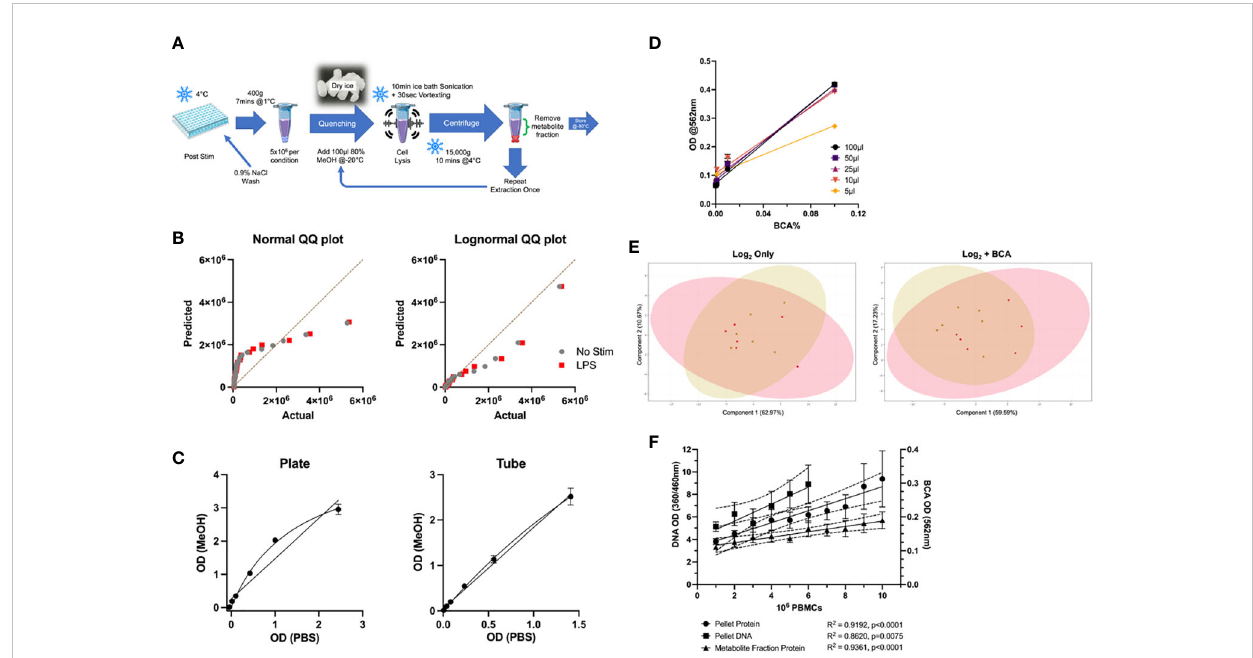
FIGURE 1 Optimisation of LC-MS Protocols for Metabolomic Pro fi ling of Primary Monocytes. (A) Overview of optimised sample preparation protocol. (B) QQ plots of targeted metabolomics data (n=24) for normality testing by Anderson-Darling test, D ’ agostino & Pearson test, Shapiro-Wilk test, and Kolmogorov-Smirnov test. (C) Comparison of plate and tube protocols for BCA assay in various protein levels in PBS and MeOH. (D) Comparison of metabolite fraction (80% MeOH) volume used for protein determination by BCA assay. (E) PCA plots comparing log2 transformed to BCA- normalised targeted metabolomics data in unstimulated (gold) and LPS-stimulated (red) monocytes. (F) Comparison of biomass normalisation methods in PBMCs for metabolomic data normalisation. Protein levels of different cell numbers in the metabolite and pellet fractions were quanti fi ed by BCA assay, and DNA levels in the cell pellet were also measured. LC-MS, Liquid chromatography mass spectrometry; BCA, bicinchoninic acid; MeOH, methanol; PCA, Principal Component